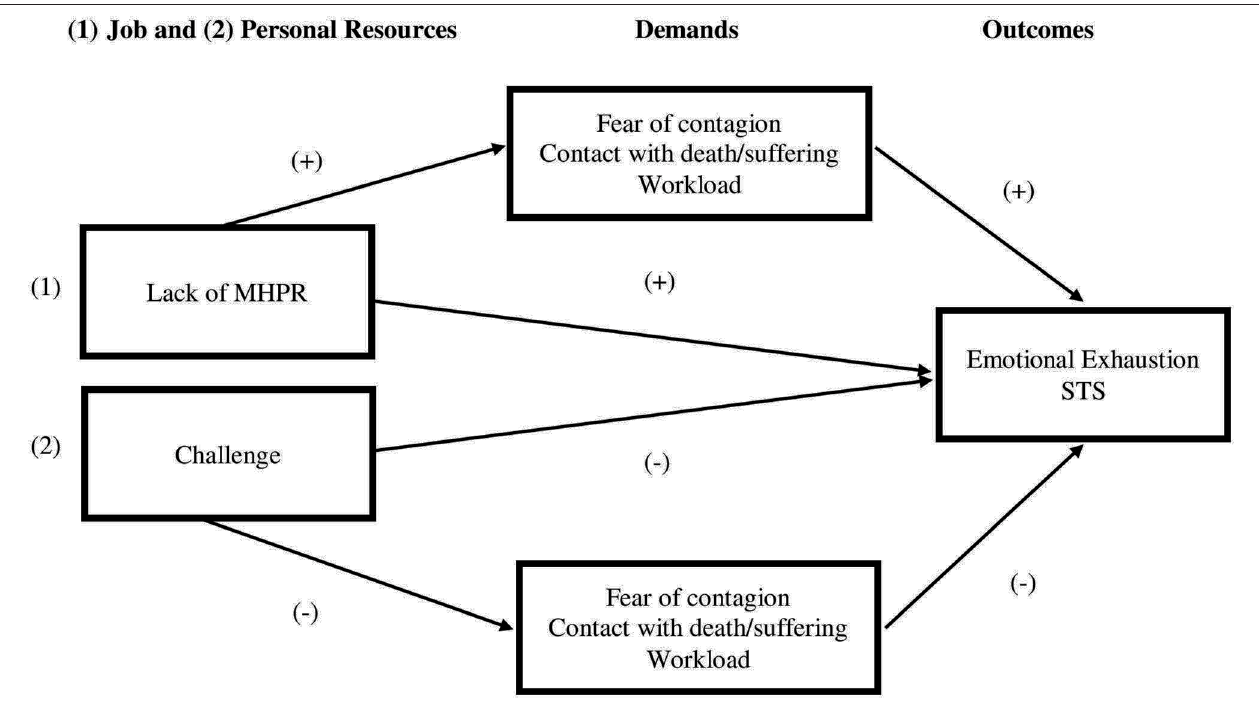
FIGURE 1 | The research model proposed. MHPR, Material and Human Protection Resources; STS, Secondary Traumatic Stress.